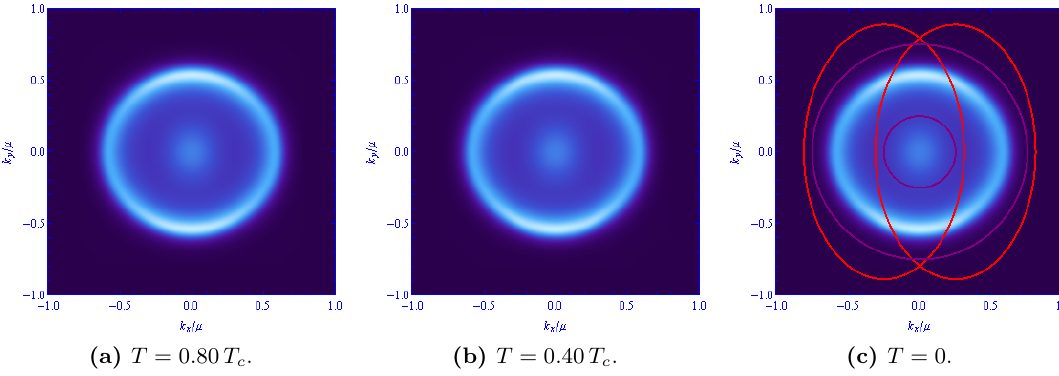
Figure 11. The spectral function for di(cid:11)erent temperatures and (cid:12)xed (cid:21) = 0 : 80 > (cid:21) c , ! = 0 : 25 (cid:22) . It remains almost unchanged for the entire range of the temperatures. The purple and red circles represent the UV and IR Dirac cones respectively.